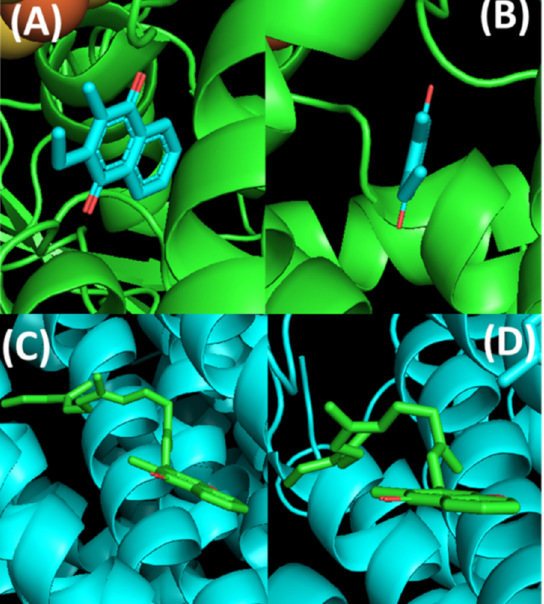
Figure 10. Conformations of MK-7 within the active sites of two different enzymes: Top: Thermus thermophilis HB27 (PDB ID: 2VPW), and Bottom: Bacillus subtilis (PDB ID: 6KOB). ( A ) MK-7 (shown in cyan) full view. ( B ) MK-7 side view showing the plausible flat conformational relationship between the headgroup and the sidechain. ( C ) MK-7 (shown in green) full view highlighting the Z conformation. ( D ) MK-7 side view to highlight the folded conformation along the bond connecting the headgroup to the sidechain. The images were created in PyMOL using the respective PDB